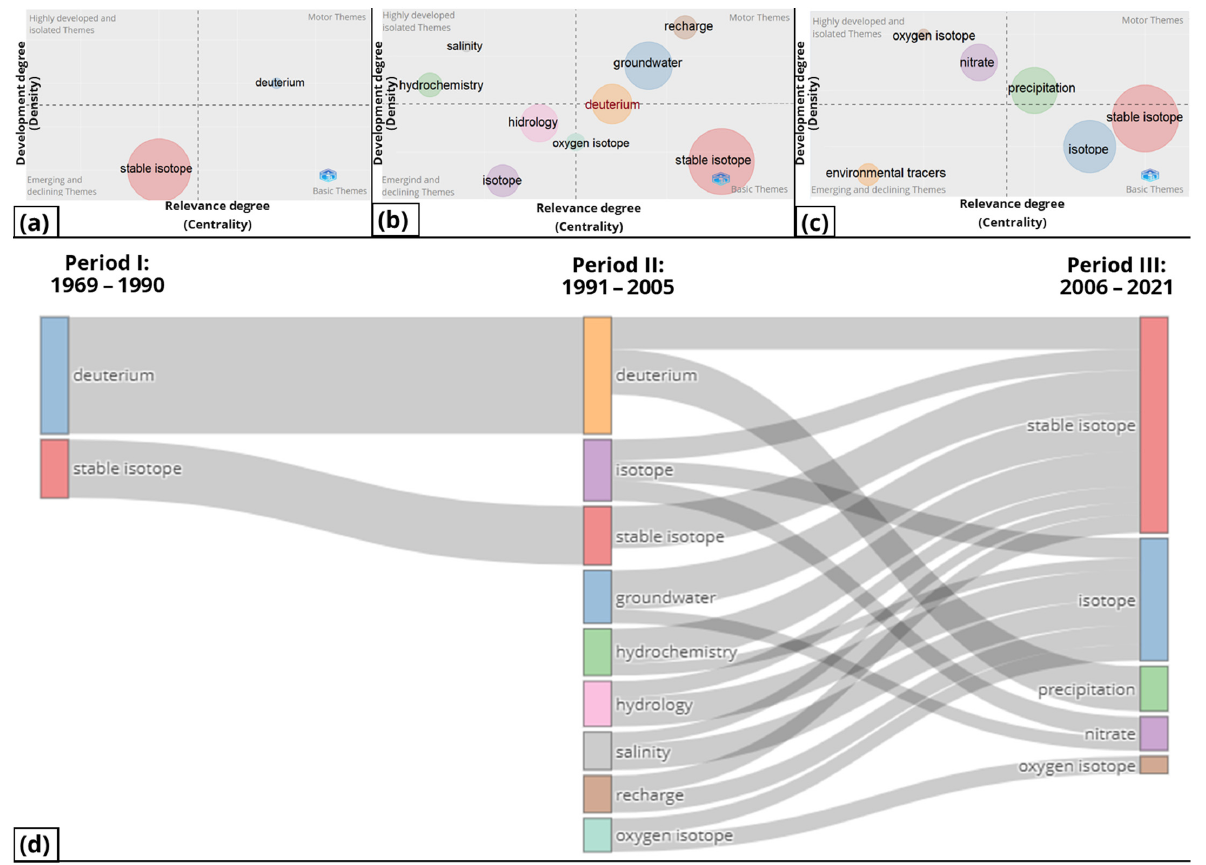
Figure 3. Thematic evolution of GSI in three periods. ( a – c ): Thematic maps (strategic diagrams). The circle size is proportional to the total frequency of terms in each theme. Each theme is labeled with the corresponding three most frequent keywords, and ( d ): Evolu- tion map (Sankey graph), where the thickness of the edges is proportional to the inclusion